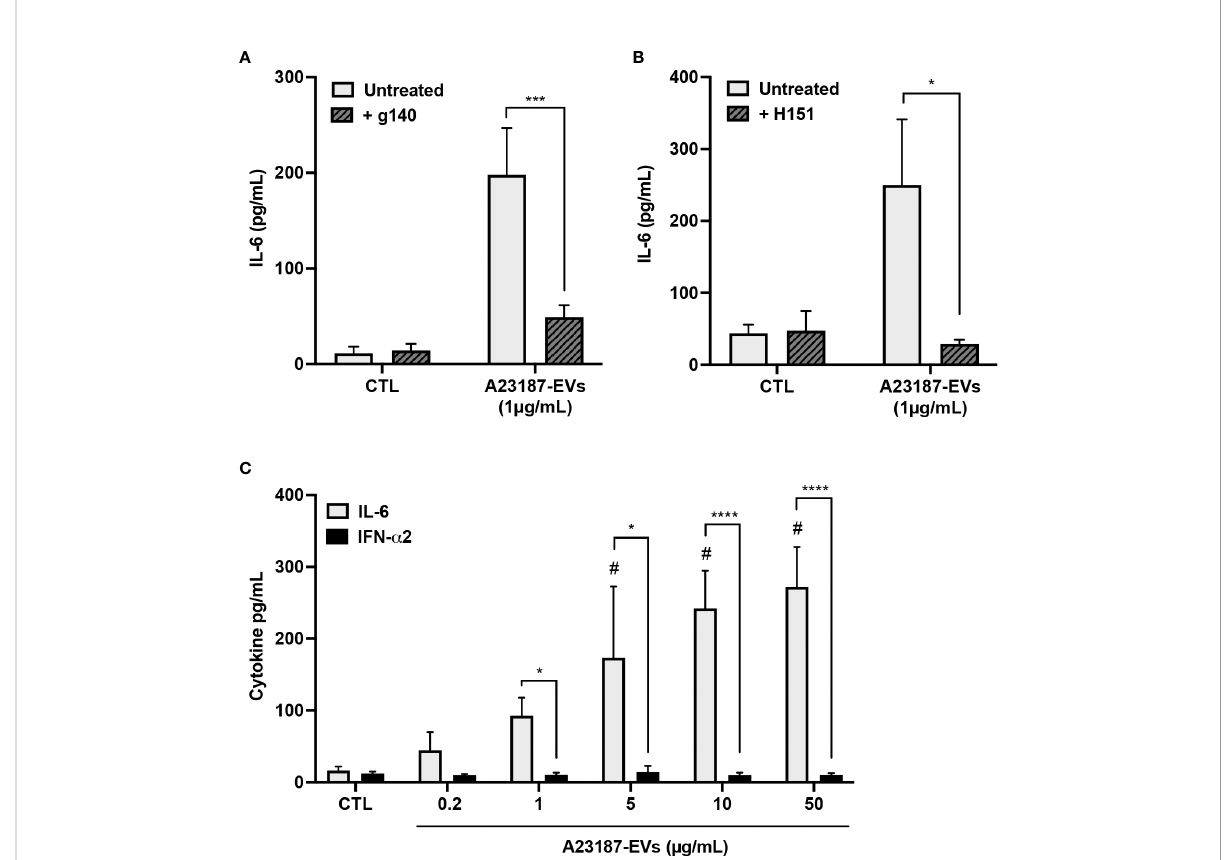
FIGURE 5 A23187-EVs cause cGAS-STING-dependent IL-6 production but do not cause IFN- a 2 production. Macrophages were left in buffer or pre-treated with the inhibitors g140 (A , cGAS inhibitor, 5µM ) or H151 (B , STING inhibitor, 1µM ) . Macrophages were treated with A23187-EVs at the indicated concentrations, supernatants were collected after 18 hours, and IL-6 analysis was performed by ELISA. Bars represent the average of seven or more experiments ± SEM. P values were determined using a two-way ANOVA with Sidak ’ s post-test (* p < 0.05, *** p < 0.001 vs. CTL). Macrophages were treated with the indicated concentrations of A23187-EVs and cytokines were measured (C , n=11 ) . Bars represent the average of experimental data ± SEM. P values were determined using a two-way ANOVA with Sidak ’ s post-test (* p < 0.05, **** p < 0.0001; # p < 0.05 vs.